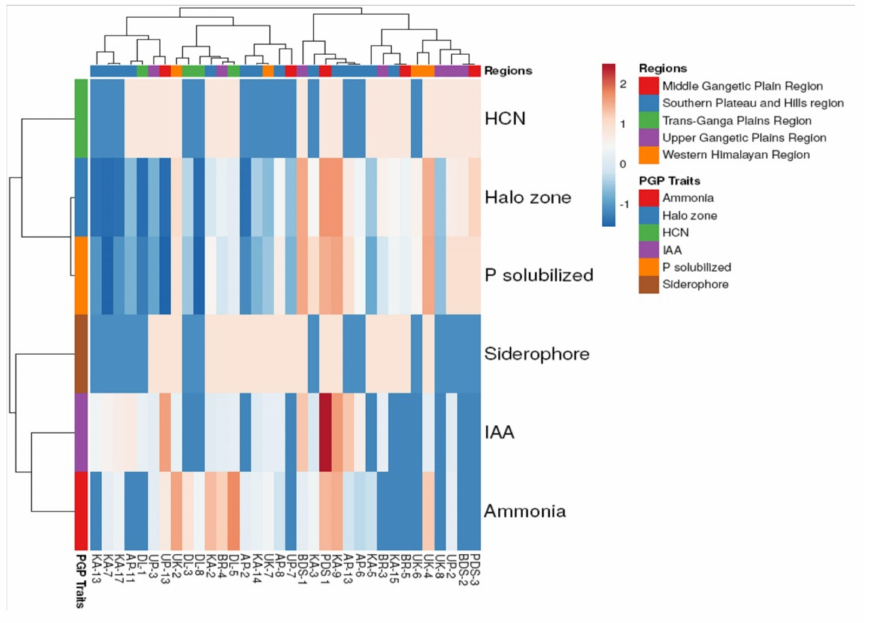
Figure 4. Clustering analysis and heatmap based on plant growth-promoting activities of rhizobacte- rial strains isolated from different